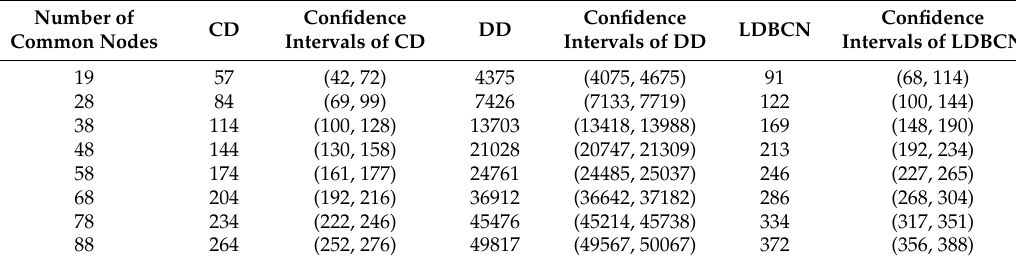
Table 2. Total communication times of common nodes for three dispatch